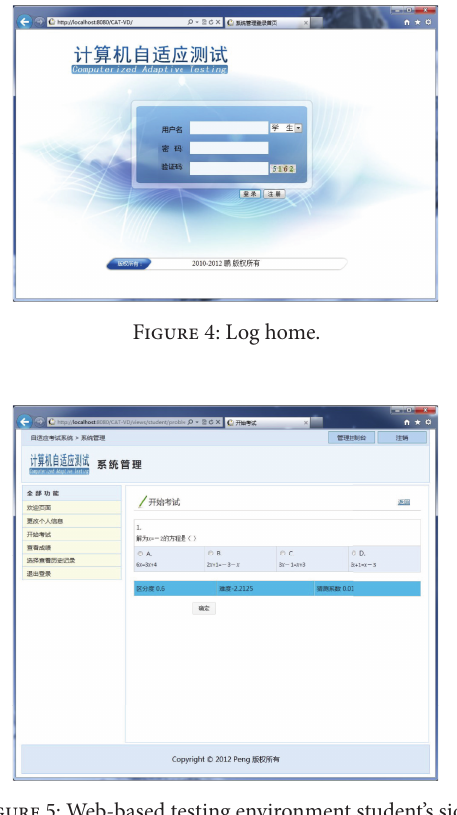
Figure 5: Web-based testing environment student’s side.